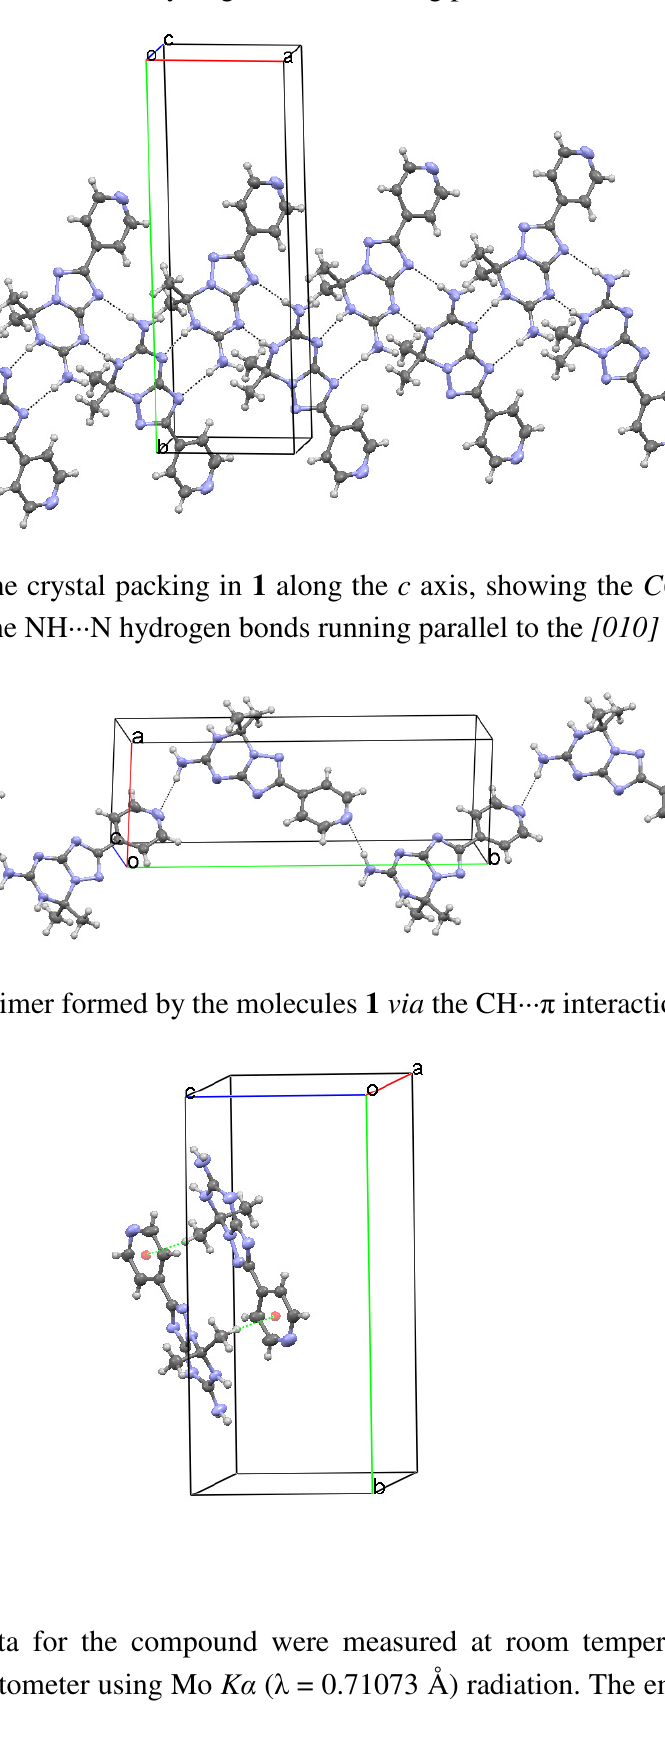
Figure 3. A view of the crystal packing in 1 along the c axis, showing the C (4) C (6) chain of molecules formed by the NH···N hydrogen bonds running parallel to the [101] direction.